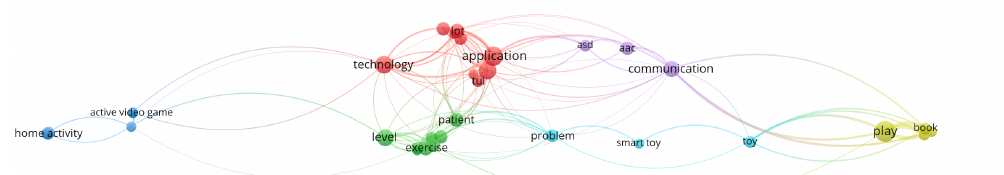
Figure 5. Network after analysis of the papers included in the literature